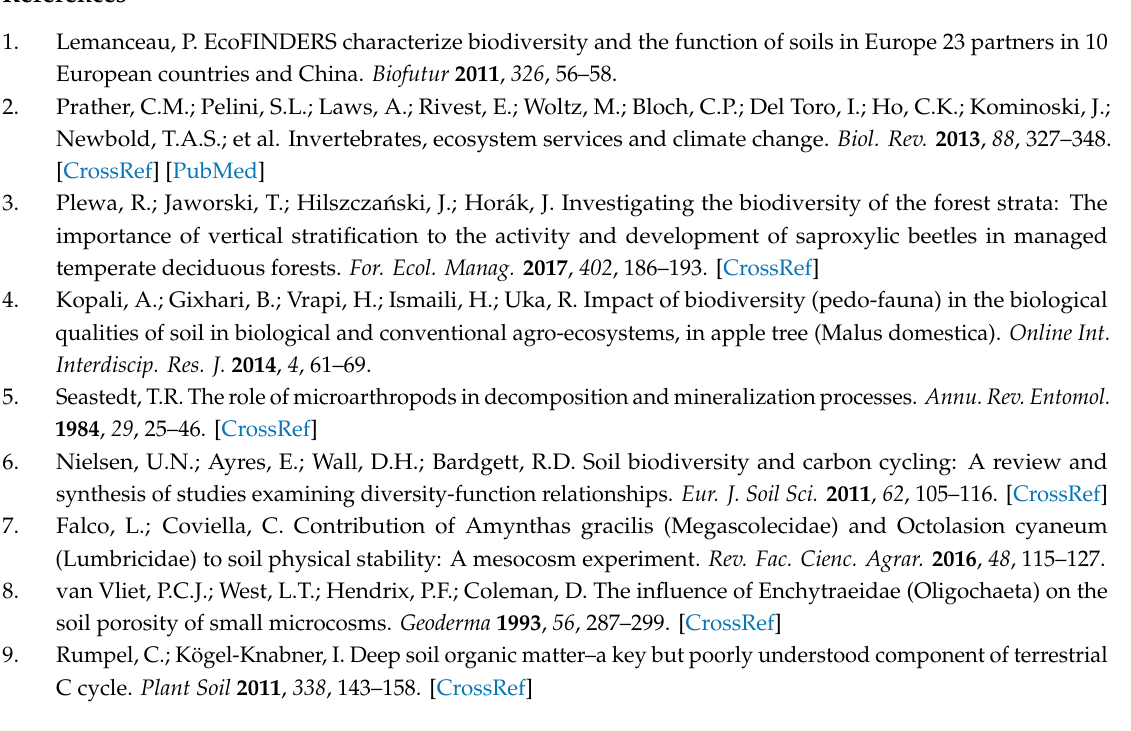
Figure S1: Soil sampling scheme, Figure S2: Community composition of Arthropods (primer ARTH02) for each habitat investigated with eDNA metabarcoding, Figure S3: Community composition of Arthropods (primer INSE02) for each habitat investigated with eDNA metabarcoding, Figure S4: Community composition of Anellida for each habitat investigated with eDNA metabarcoding, Table S1: Distribution of plots per habitat type, Table S2: Distribution of eDNA samples per layer, Table S3: E ff ects of environmental features of forests in the CCA analysis (** = p < 0.05), Table S4: E ff ects of environmental features of grasslands in the CCA analysis (** = p < 0.05; * = p <